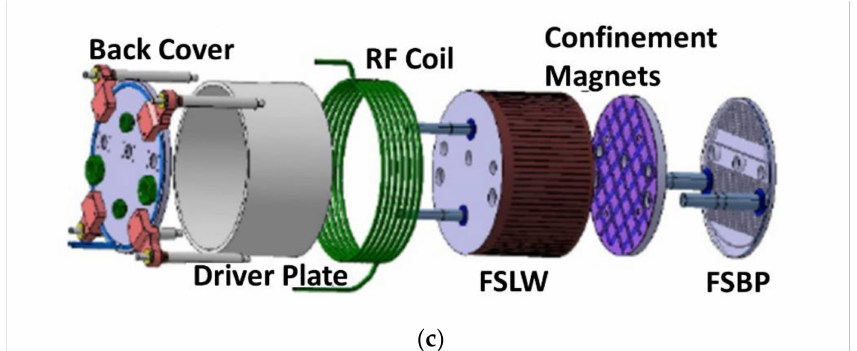
Figure 1. ( a ) Exploded view of SPIDER Beam Source; ( b ) Drivers Plate rear view on the left and front view on the right; ( c ) exploded view of one driver